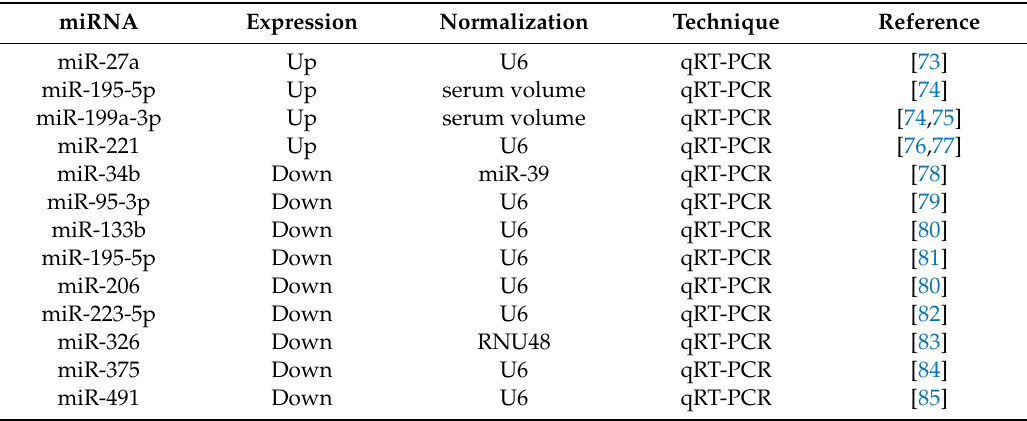
Table 1. miRNAs in serum or plasma derived from osteosarcoma